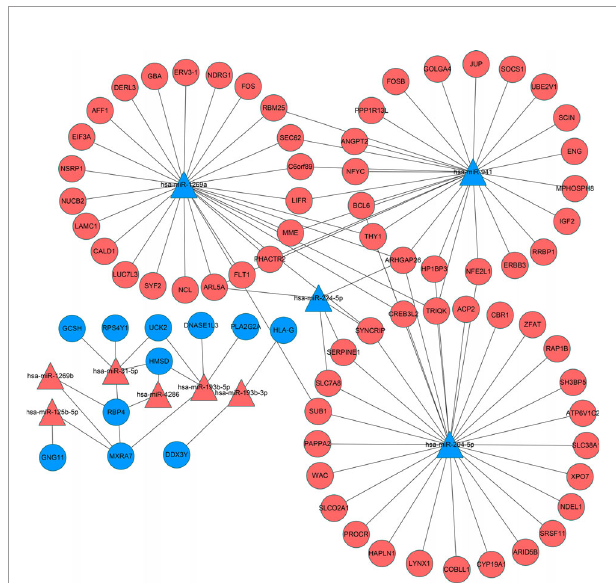
FIGURE 5 | Interaction networks of miRNA and target DEGs in IVF-ET placenta tissues. microRNAs are represented by triangles and mRNAs are represented by circles. Red indicates genes with up-regulated expression and blue indicates genes with down-regulated expression. miRNA, microRNA; mRNA, messenger RNA; IVF-ET, in vitro fertilization- embryo